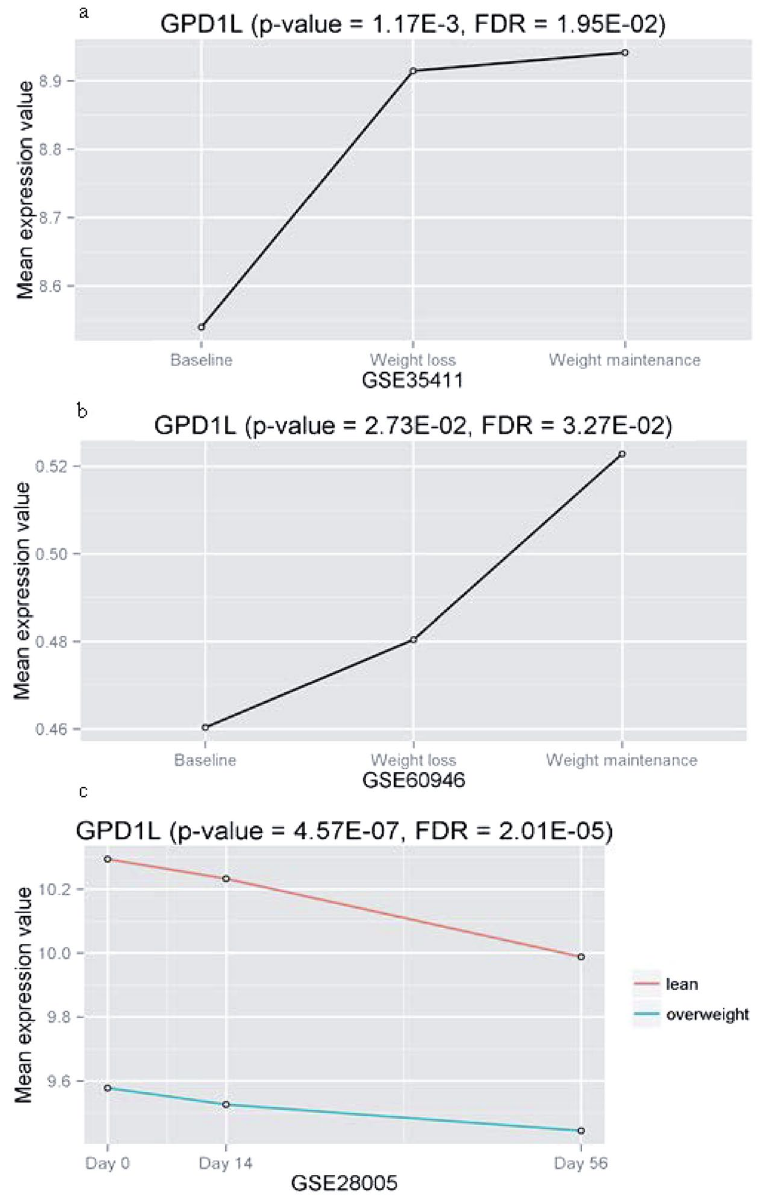
Figure 4. The most promising candidate gene for obesity, GPD1L . ( a and b ) The differential gene expression patterns in adipose tissue from obese human subjects during weight loss and weight maintenance in experiment 2 (GSE35411) and experiment 3 (GSE60946), respectively. ( c ) The differential expression pattern between overweight and lean subjects over day 0, 14 and 56. (experiment 4,